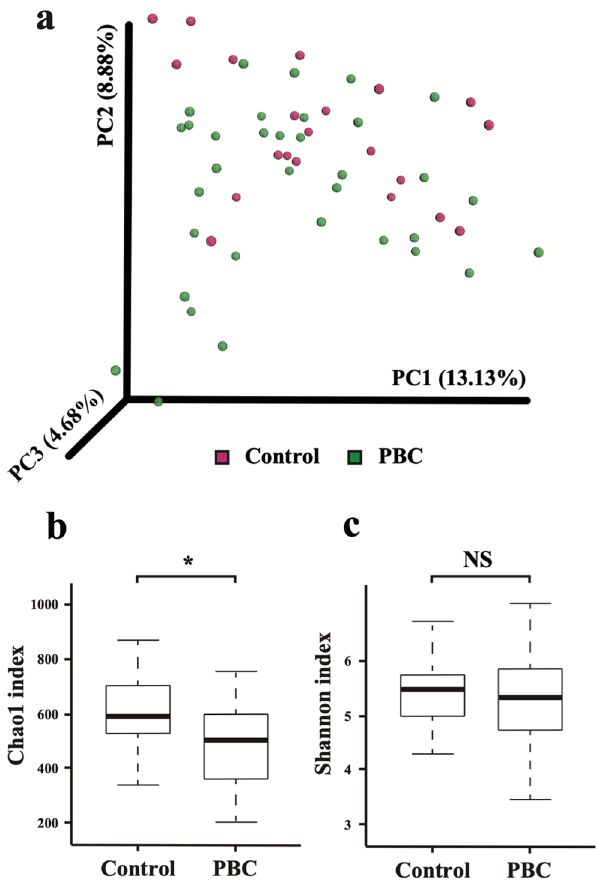
Figure 1. Comparison of MAM diversity between patients with PBC and HCs. ( a ) Principal coordinate analysis of unweighted UniFrac analysis using Emperor (0.9.60, http:// bioco re. github. io/ emper or/ build/ html/ scrip ts/ make_ emper or. html) showed a somewhat weak clustering of the MAM between the patients with PBC and HCs (pseudo-F: 1.44, P = 0.054, PERMANOVA). ( b ) Changes in the mucosa-associated microbiota diversities in patients with PBC ( n = 34) compared with HCs ( n = 21). An α-diversity, illustrated by microbial richness (Chao-1 index), was reduced in the PBC group ( P = 0.039, Wilcoxon rank-sum test). * P < 0.05. ( c ) No difference in index (Shannon) of diversity. MAM, mucosa-associated microbiota; PBC, primary biliary cholangitis; HC, healthy control; PERMANOVA, permutational analysis of variance.